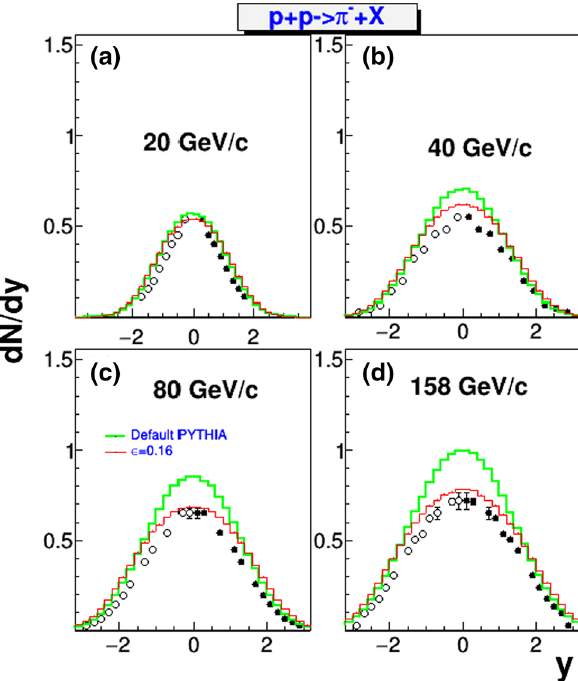
Fig. 3 The transverse mass spectra of π − in inelastic pp-collisions at mid-rapidity (0 < y < 0 . 2). The small-dashed and solid lines denote theGaussianandthermalmodelswithadjustedwidth σ andtemperature ( T ), respectively. The closed points represent NA61/SHINE [9] data. For better readability, both the calculations and data points were